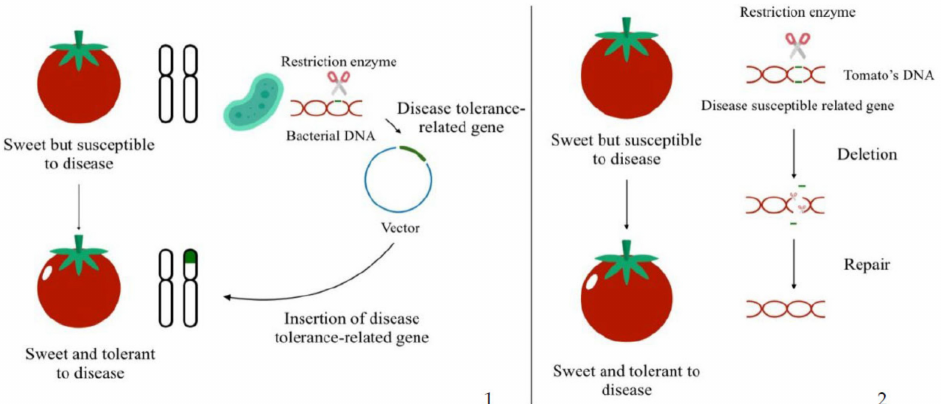
Figure 5. An illustration of the two main genetic modification methods: (1) gene addition and (2) gene silencing. Icons made by Freepik and Smashicons from www.flaticon.com (accessed on 1 December 2021). Adapted from